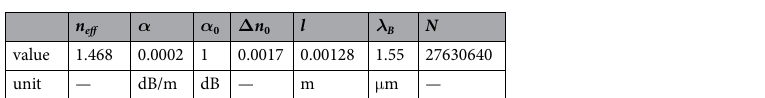
Table 1. Parameters of fiber gratings in theoretical calculations and